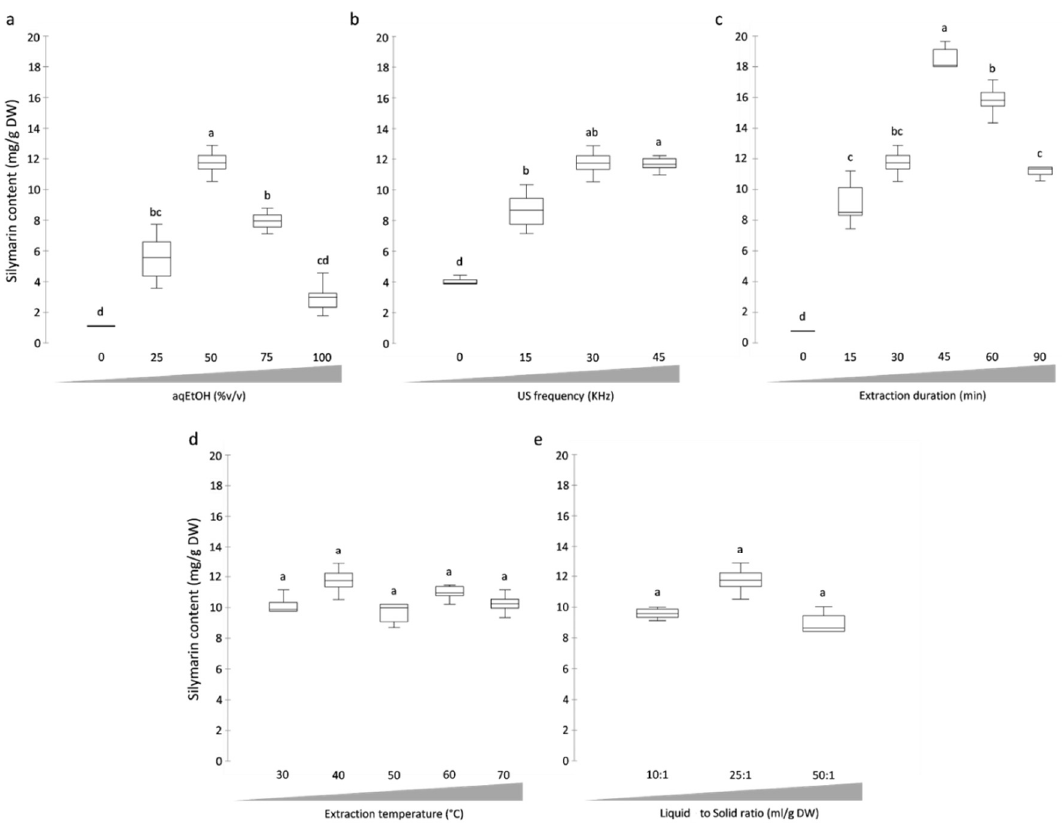
Figure 2. Silymarin (SILM) contents extracted from mature fruits of S. marianum as of function of ( a ) aqEtOH concentration (% (v/v)), ( b ) US frequency (kHz), ( c ) extraction duration (min), ( d ) extraction temperature (°C) and ( e ) liquid to solid ratio (mL/g DW). The complete description of each extraction conditions is presented in the text. Values are means ± SD of 6 independent replicates. Different letters (a–d) represent significant differences between the various extraction conditions ( p < 0.05).